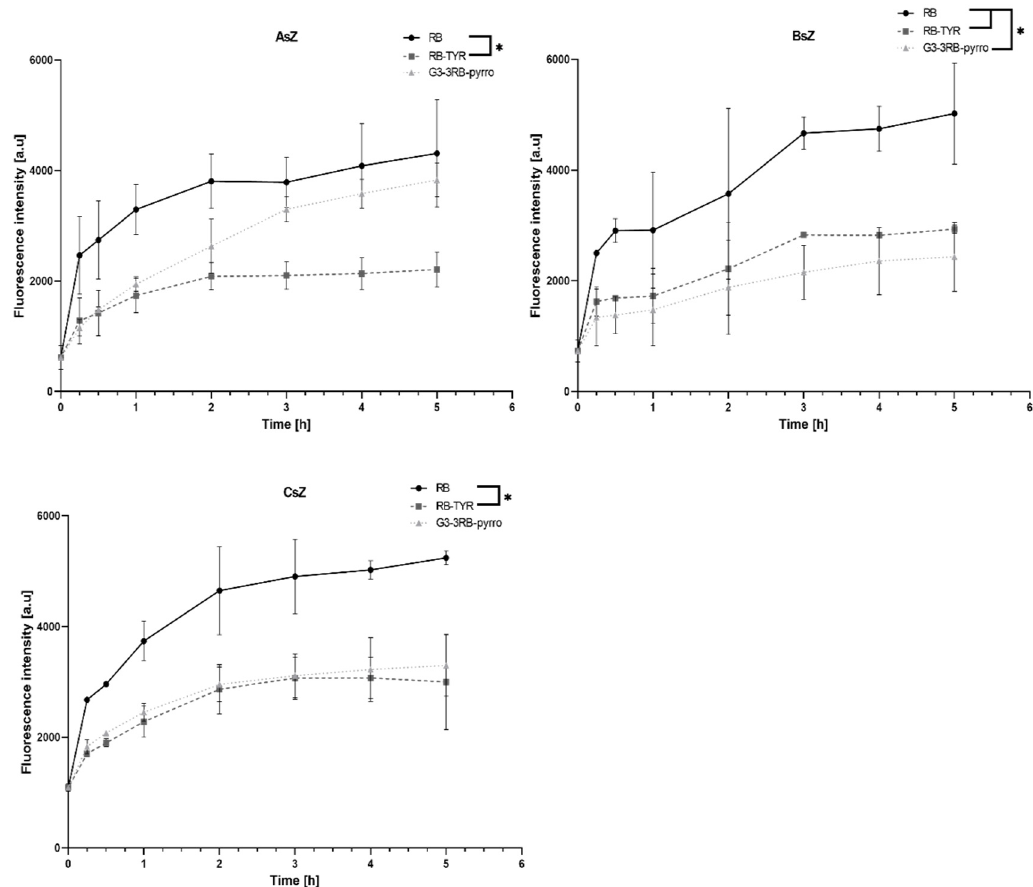
Figure 8. Cellular uptake of tested compounds (RB, RB–TYR, G3–3RB–pyrro at 5 µM final concentration of RB) by AsZ, BsZ and CsZ cell lines. Data presented as mean ± SD. * p < 0.05.